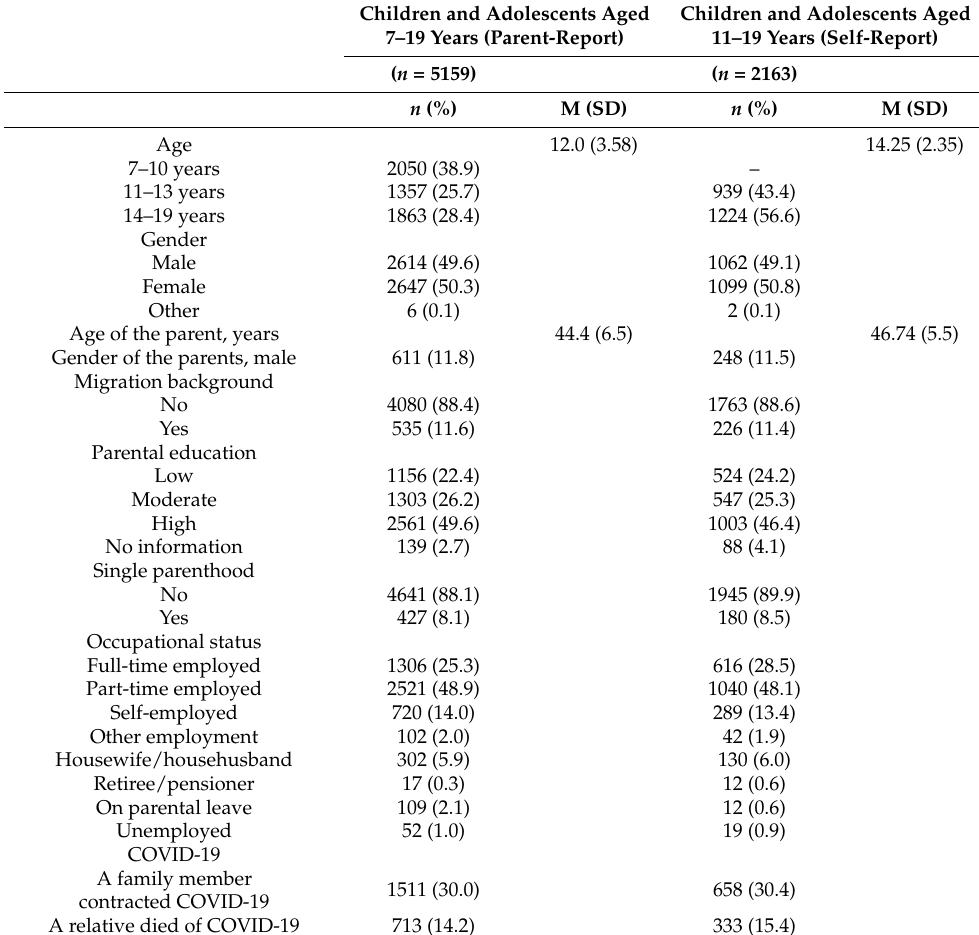
Table 1. Sociodemographic characteristics of the COPSY South Tyrol 2021